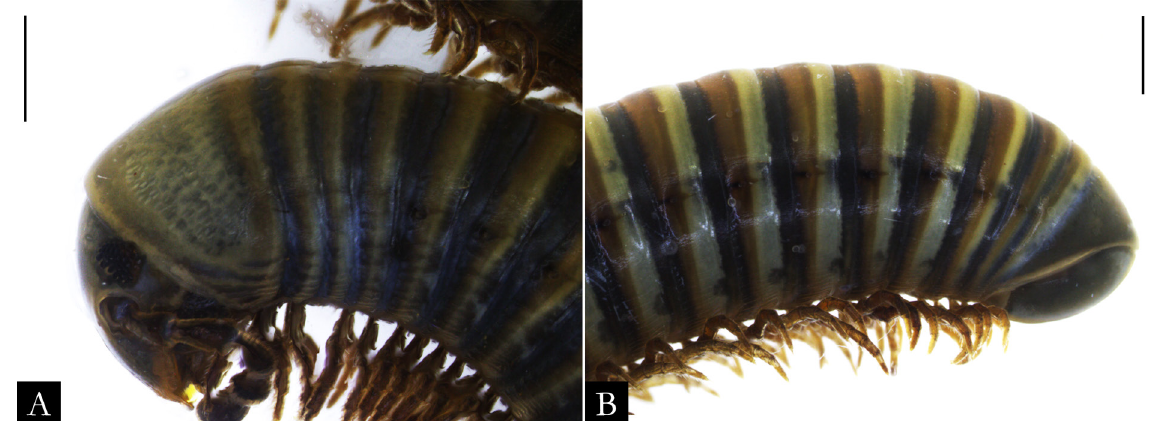
Fig. 151. Pseudonannolene curvata sp. nov., holotype, ♂ (MCN), in lateral view. A . Anterior region. B . Posterior region. Scale bars = 1